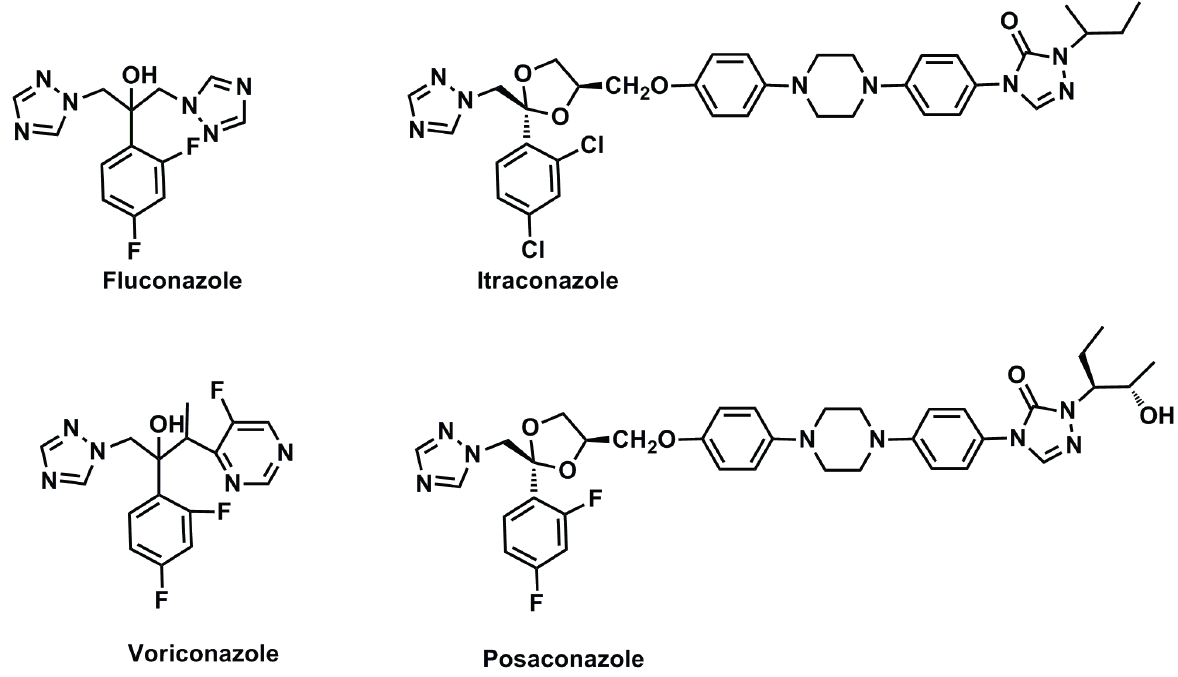
Figure 1. Triazole antifungal agents used in clinical